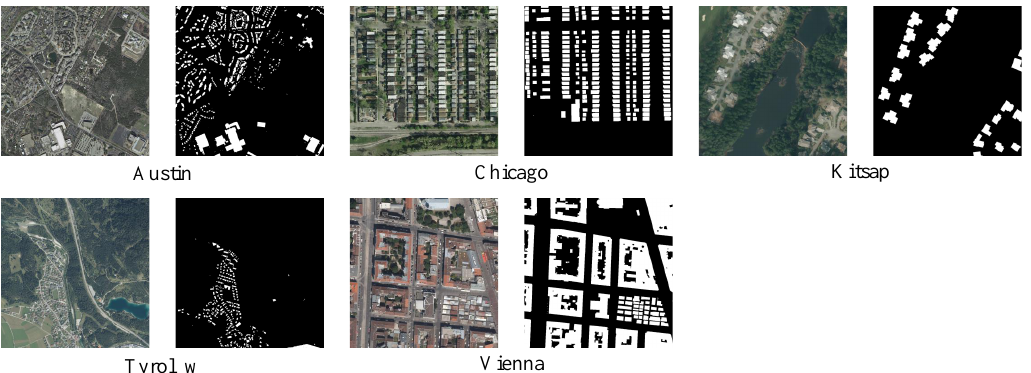
Figure 3. Examples and their ground truth of the Inria dataset. Left: Image, Right: Ground truth. The Massachusetts dataset consists of 151 aerial RGB images and corresponding semantic labels.